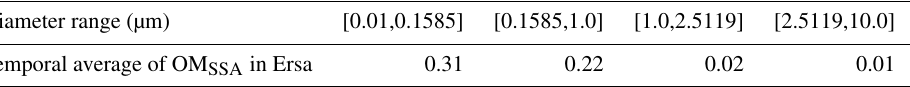
Table 5. Temporal averages of OM SSA near Ersa using the parameterisation of Gantt et al. (2012) as a function of aerosol particle diameter, over the summer of 2013 (from 6 June to 3